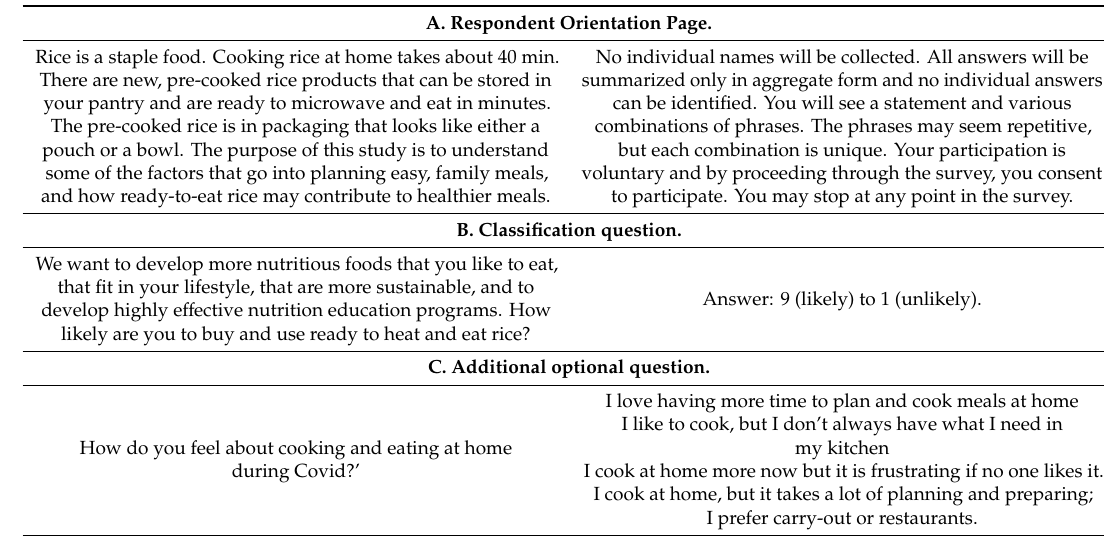
Table 4. Respondent orientation and classification